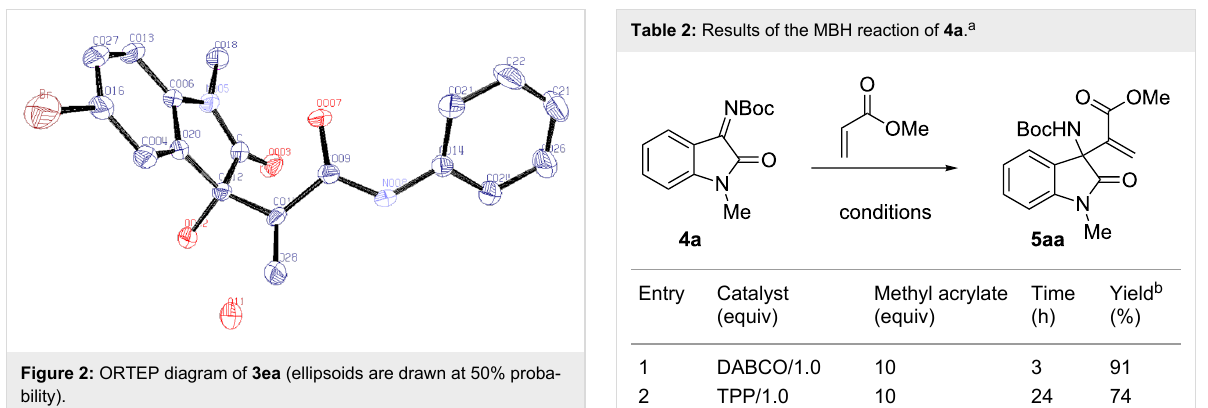
MBH product 5aa in high purity and in 91% yield in just 3 hours of reaction (Table 2, entry 1) was achieved.